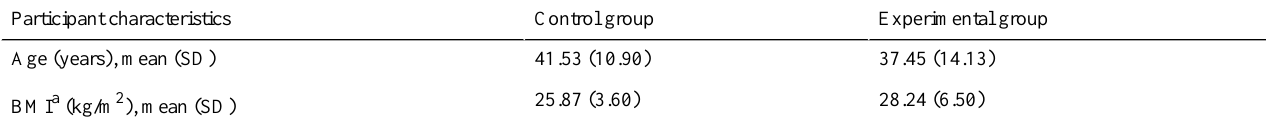
Table 3. Mean age and body mass index of